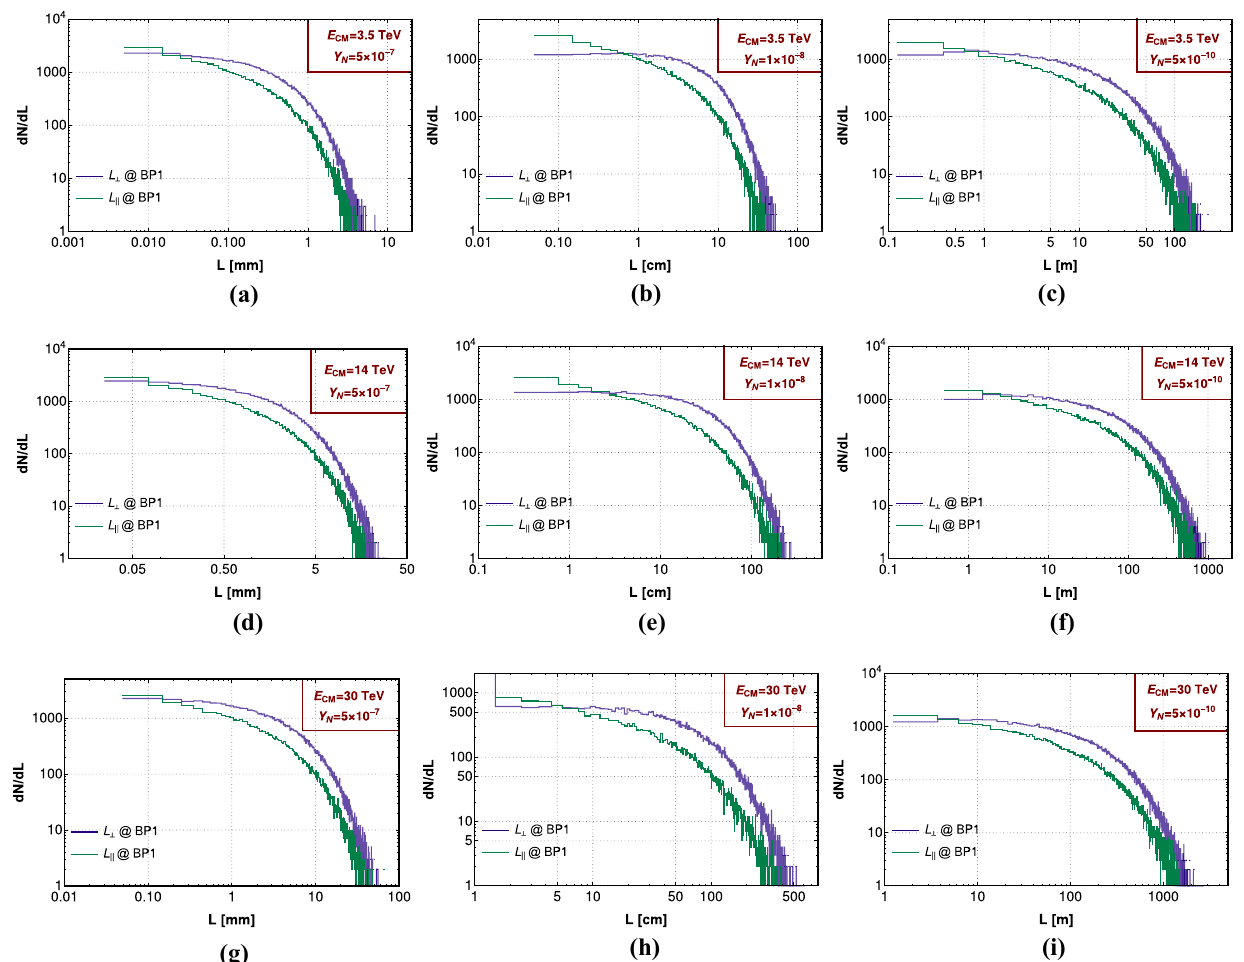
Fig. 24 Displaced total transverse ( L ⊥ in purple) and longitudinal ( L (cid:12) in green) decay length distributions for the SU ( 2 ) L triplet heavy fermions N ± , at the muon collider with the centre of mass energies of 3.5 TeV ( a – c ), 14 TeV ( d – f ) and 30 TeV ( g – i ) for BP1 ( M N = 1 TeV).